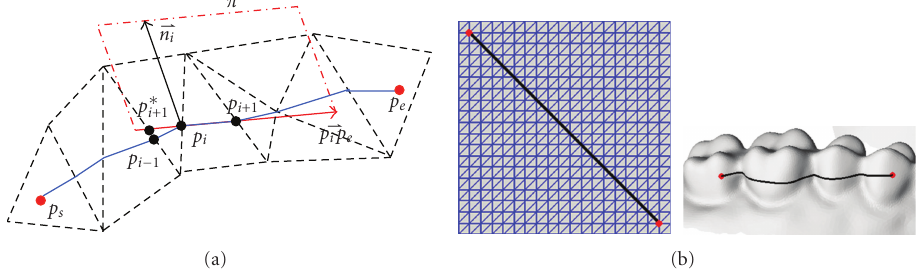
Figure 6: (a) Concept of the direction tracing method (b) Examples of “line” solved on the planar and spatial surface.